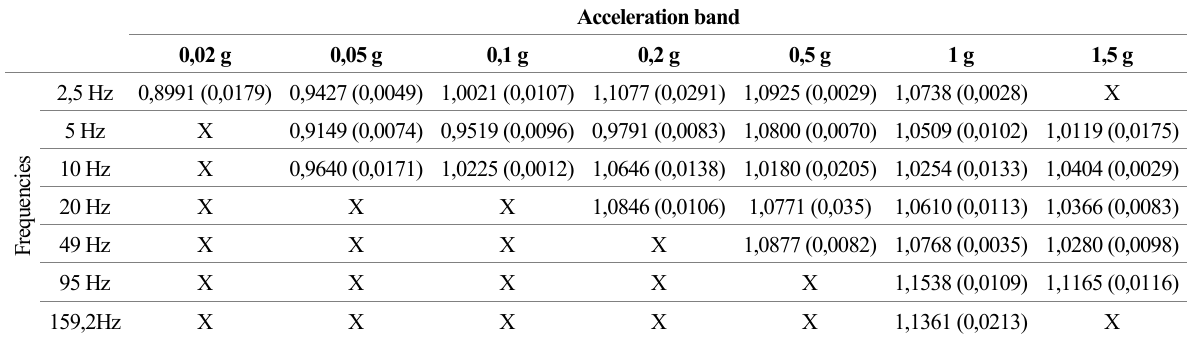
Table 4. Multiplication Factors for the MPU-6050 (average and standard-deviation values).